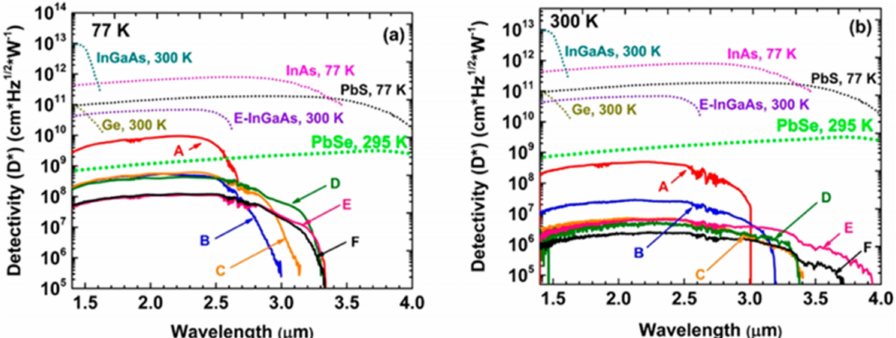
Figure 18. Specific detectivity for a GeSn photoconductive detector at the temperatures of ( a ) 77 K and ( b ) 300 K (the Sn contents for samples A–F were 12.5%, 15.9%, 15.7%, 17.9, 20.0%, and 22.3%, respectively). Reproduced with permission from [63], American Chemical Society, 2019.